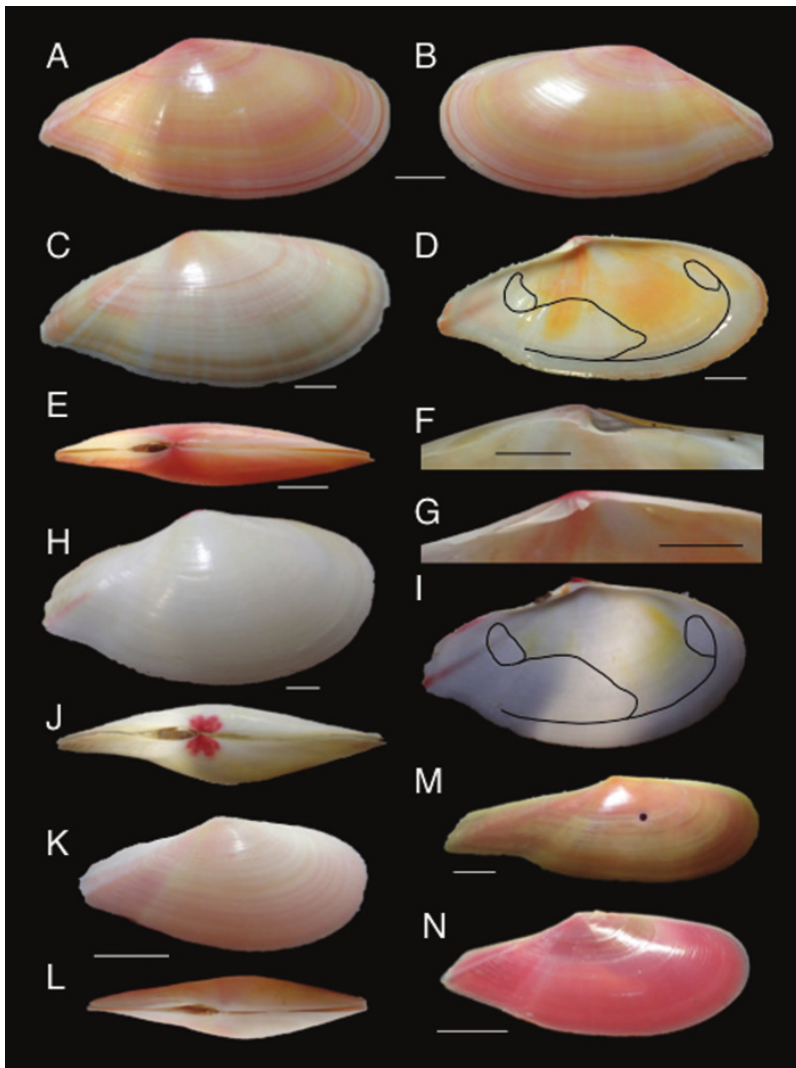
Figure 3. Right ( A, C, F, H, K, M, N ), left ( B, D, G, I ), and paired ( E, J, L ) valves of tellinid species: A–G Pharaonella amanyu H–J Tonganaella tongana K–L T. perna M P. aurea N P. sieboldii . Scale bar 10 mm. right valve weakly commarginal ridged on rostrum; exterior color orange to pink, some- times with fine pale rays emanating from umbo (although the colour of the shell tends to fade once the animal has died); periostracum thin, shiny, slightly iridescent; interior orange to pink with yellow tint in central section; umbones small, posteriorly displaced and touching each other; hinge ligament external, short, and situated in ligamental groove; right valve hinge with 2 elongate lateral teeth, 1 oblique anterior cardinal tooth plus 1 bifid posterior cardinal tooth (Fig. 3F); left valve hinge with 2 distal